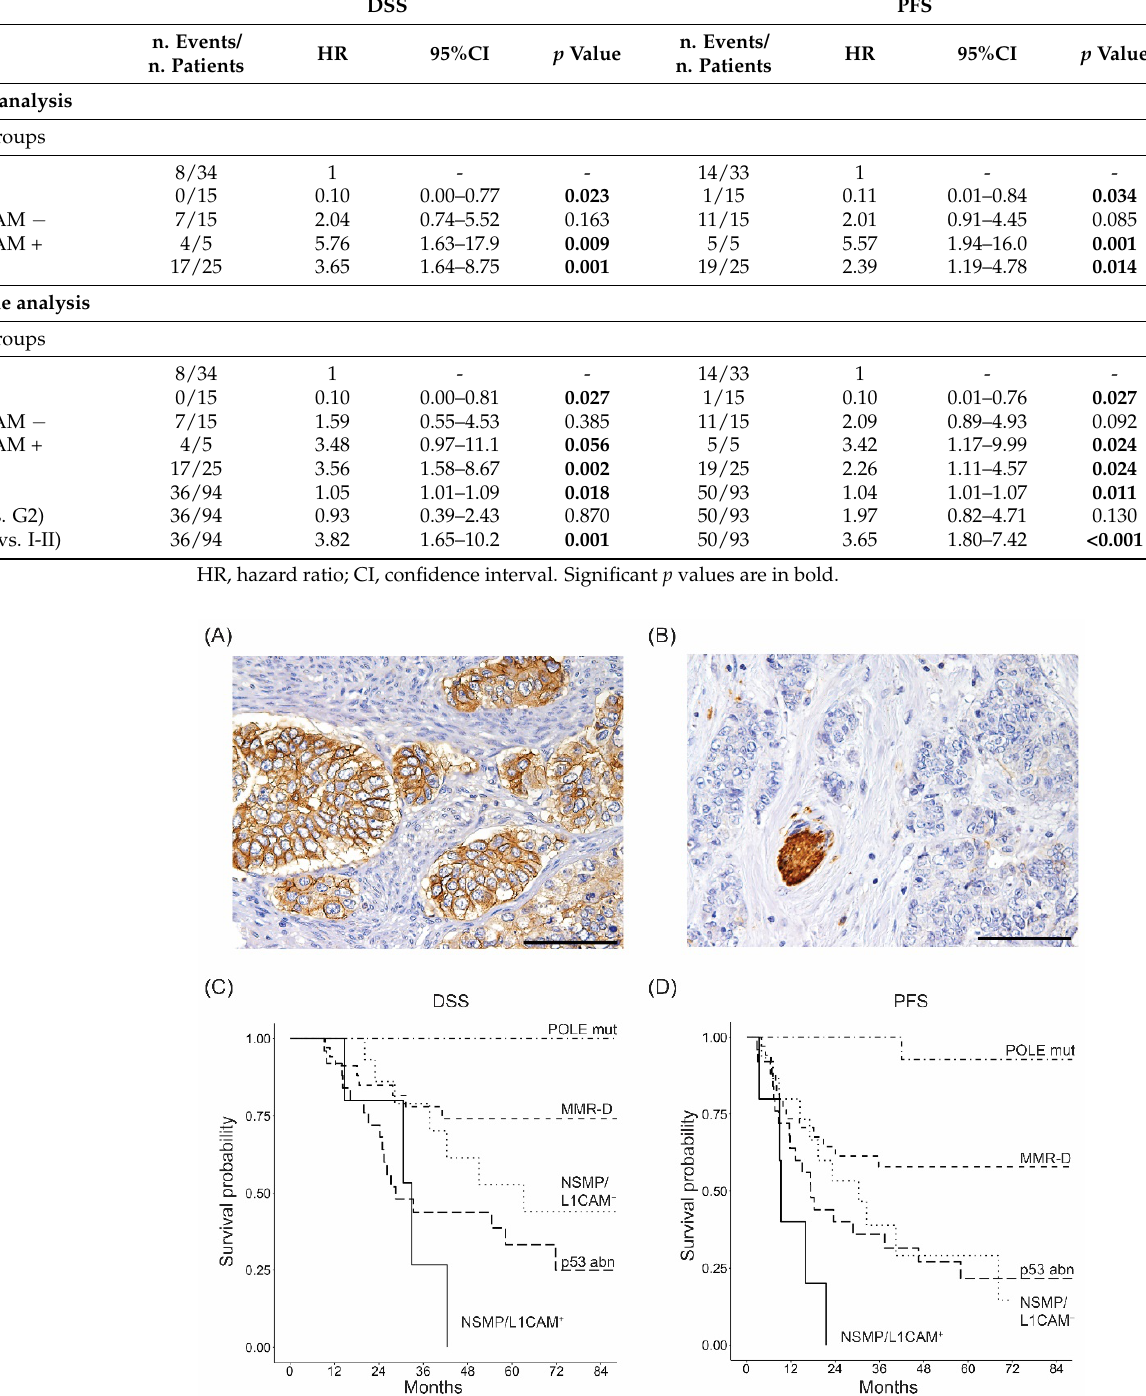
Table 5. Univariable and multivariable survival analysis for disease-specific survival (DSS) and progression-free survival (PFS), considering the molecular classification with NSMP subgroup strati- fied based on L1CAM positivity on the Brescia Cohort. DSS PFS